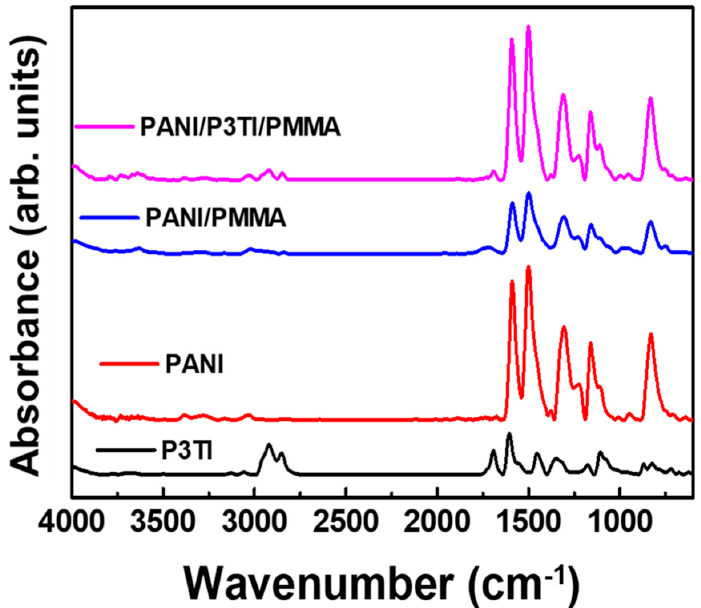
Polymers 2020 , 12 , x FOR PEER REVIEW Figure 2. FTIR spectra of PANI / PMMA, PANI / P3TI / PMMA, pristine PANI, and P3TI. Figure 2. FTIR spectra of PANI/PMMA, PANI/P3TI/PMMA, pristine PANI, and P3TI.